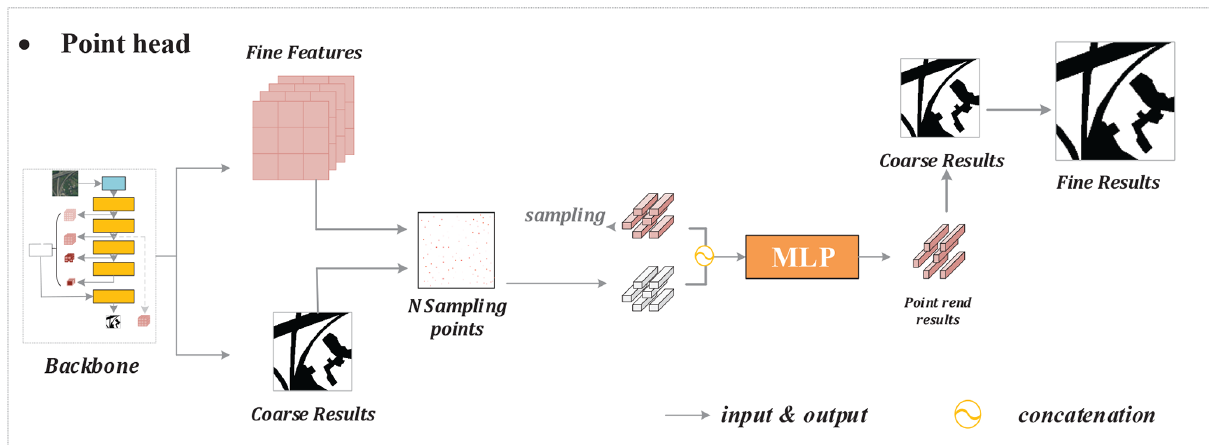
Figure 7. Structure of the point head in UGSNet. The image in the backbone was retrieved from © Gaofen-2 2019. Given the fine features and the coarse UGS results from the backbone, the point head will firstly collect N ( = 1024) sampling points with the lowest certainty to construct point-wise features, which will be input into a multilayer perceptron (MLP) for classification and help obtain fine UGS